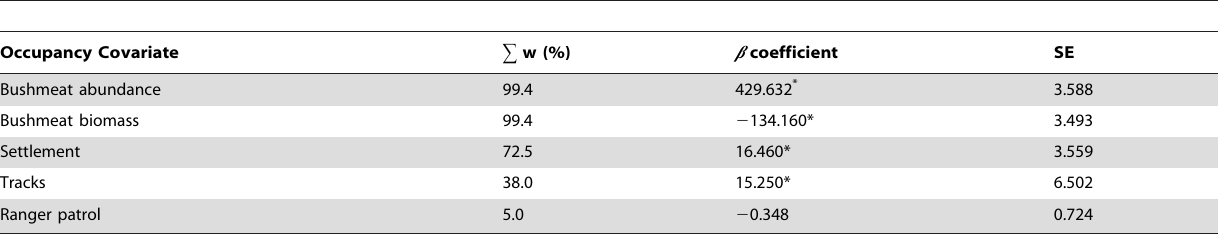
Table 2. b - coefficient estimates for covariates influencing bushmeat poaching site use ( weights ( g